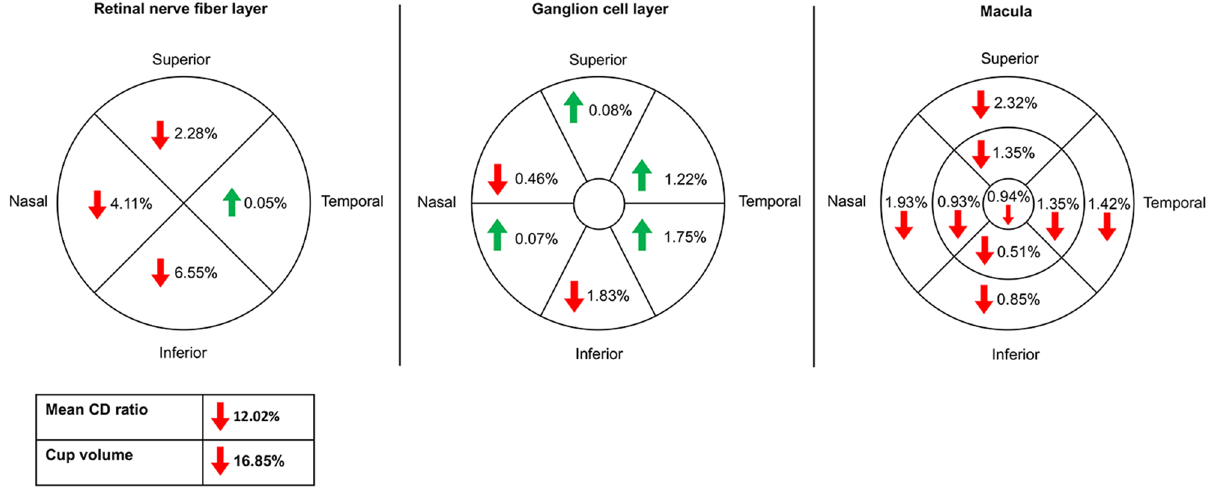
Figure 2. Percent change in optical coherence tomography measurements in Gulf War Illness. Percent change in optical coherence tomography (OCT) measurements Gulf War Illness (GWI) compared to controls. RNFL: n = 27 GWI and 36 controls. GCL: n = 26 GWI and 37 controls. Macula: n = 27 GWI and 38 controls. indicates a decreased percent change for GWI compared to controls. indicates an increased percent change. CD = cup- to-disc; OCT = optical coherence tomography. Figure was created using Microsoft PowerPoint for Mac (version 16.16.15, https:// www. micro soft. com/ en- us/ micro soft- 365/ power point).